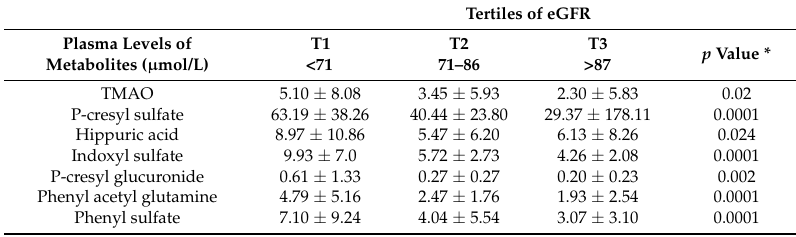
Table 3. Plasma levels of the intestinal metabolites by tertiles of estimated glomerular filtration